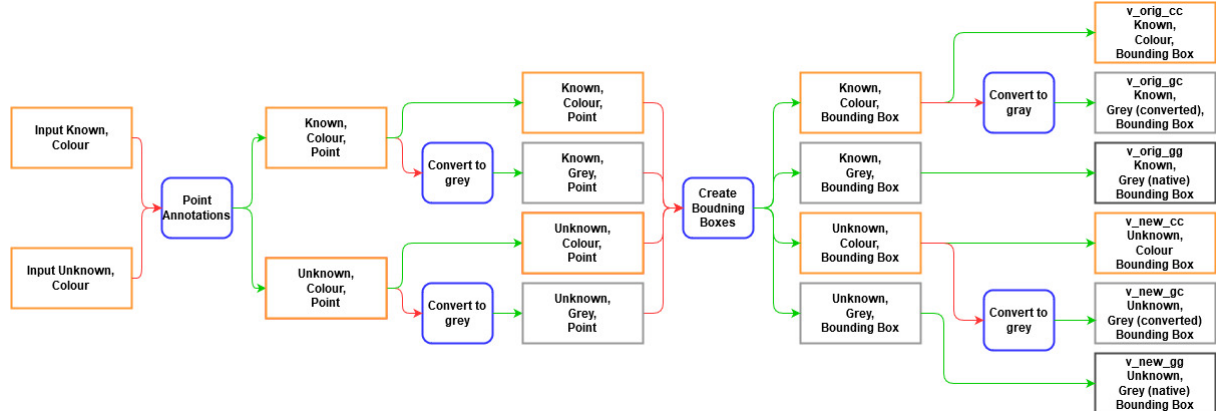
Figure 3. Workflow for creating the validation sets used for